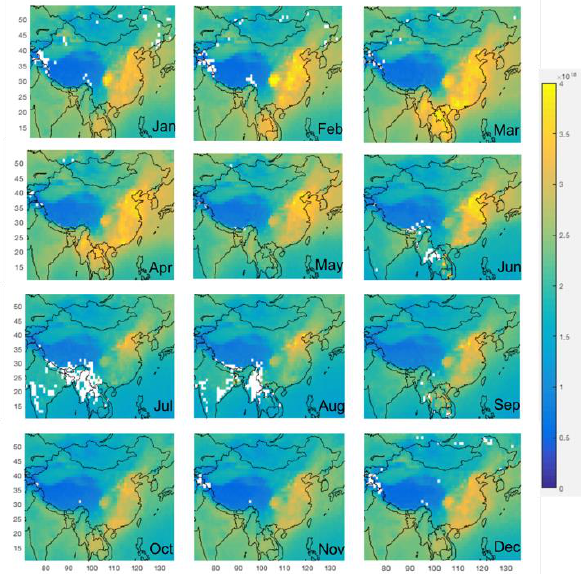
Figure 4: Month-by-month mean values of the CO total column over our region of interest( mol/cm 2